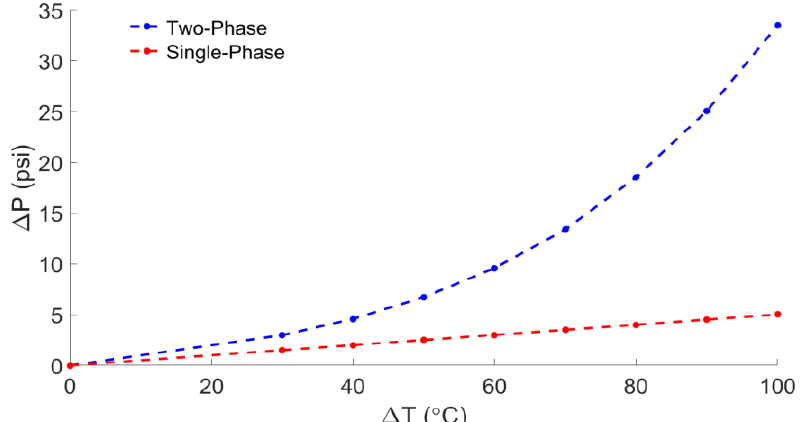
Figure 1. Calculated pressure change as a function of the temperature change inside a rigid, closed container for single-phase (air only) and two-phase (water – air mixture) regimes.